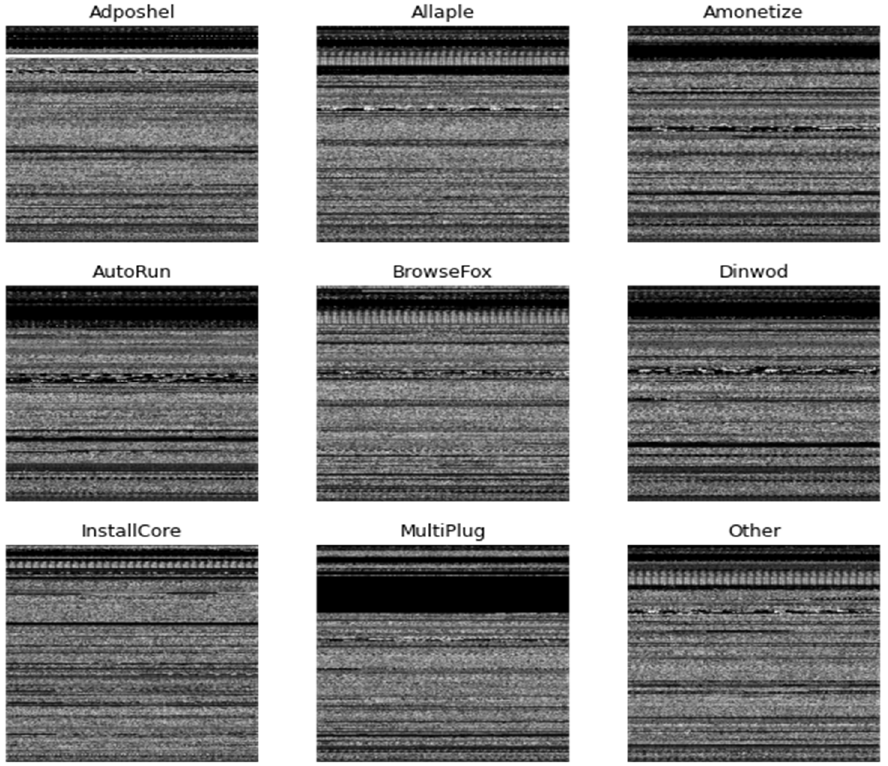
Figure 5. Transformation of dump files into images.